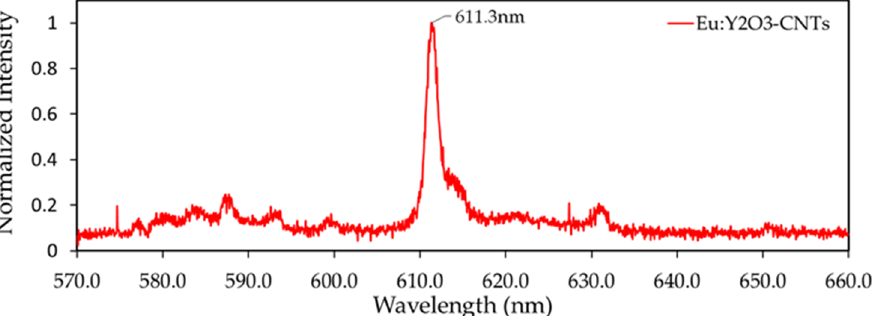
Figure 7. Photoluminescent spectra resulting from 229 nm excitation of 5%wt Eu:Y 2 O 3 CNTs that had been activated for 2.5 h.